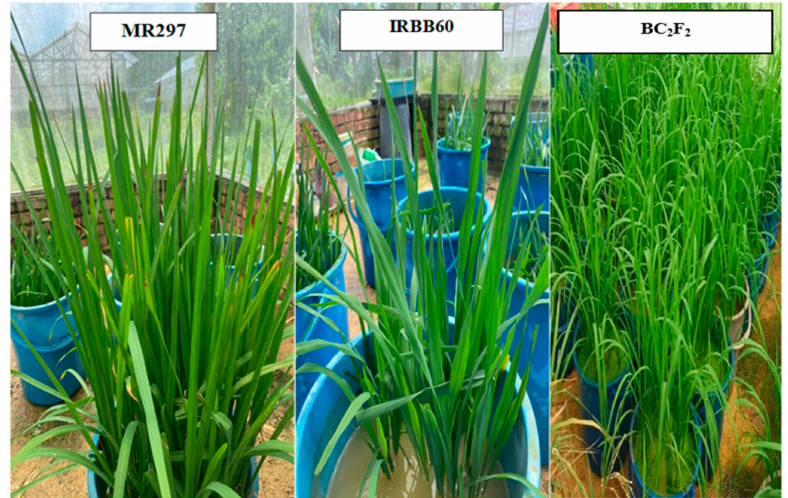
Figure 8. MR297, IRBB60, and the selected BC 2 F 2 plants.